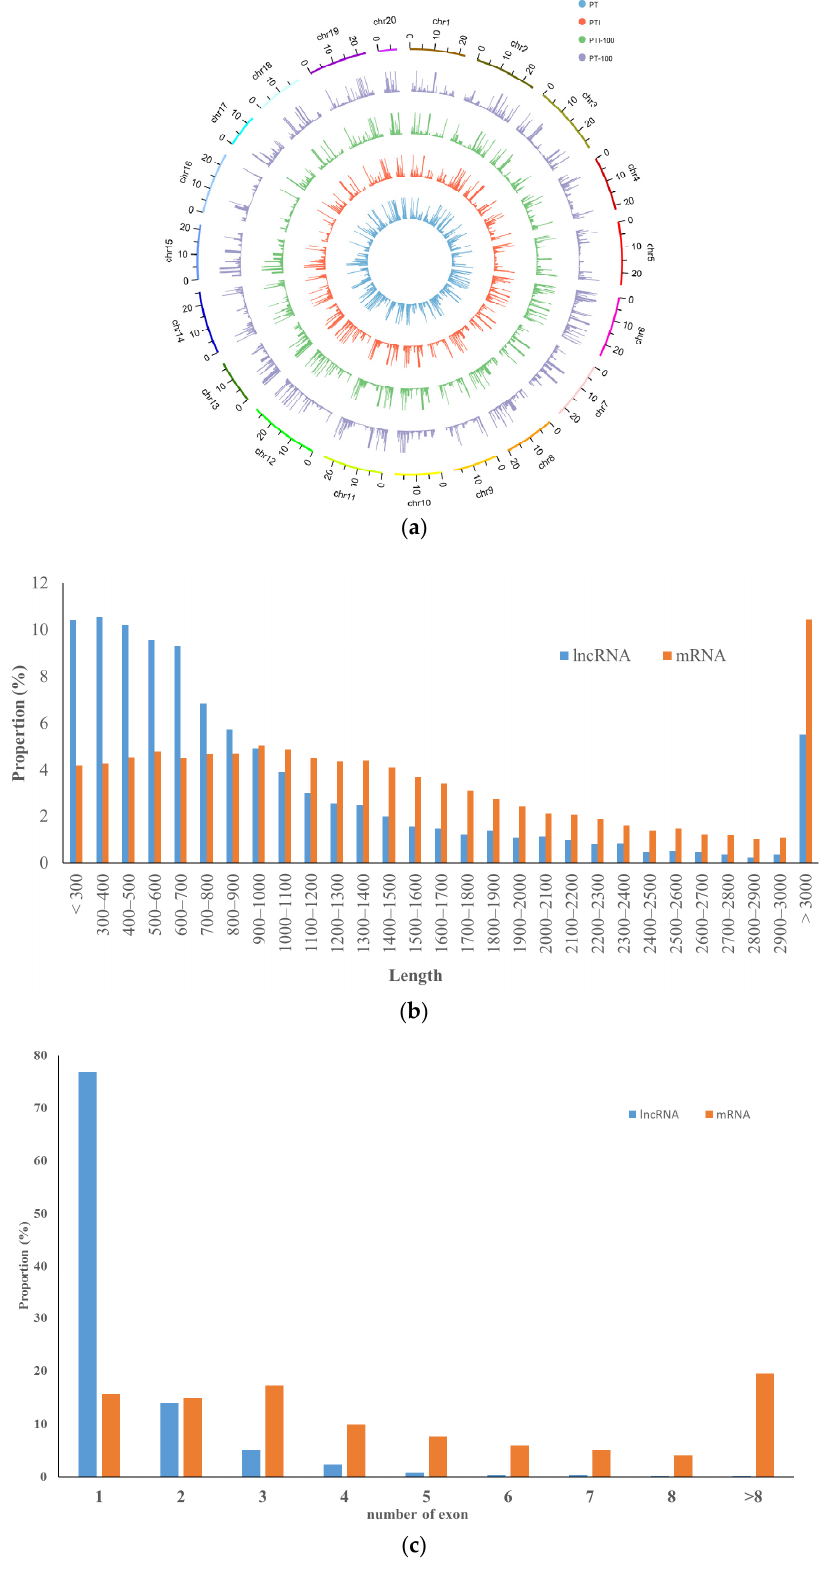
Figure 3. Characteristics of Paulownia lncRNAs. ( a ) Distribution of lncRNAs along each chromosome; ( b ) Transcript length distribution of lncRNAs and mRNAs; ( c ) Number of exons per transcripts for lncRNAs and